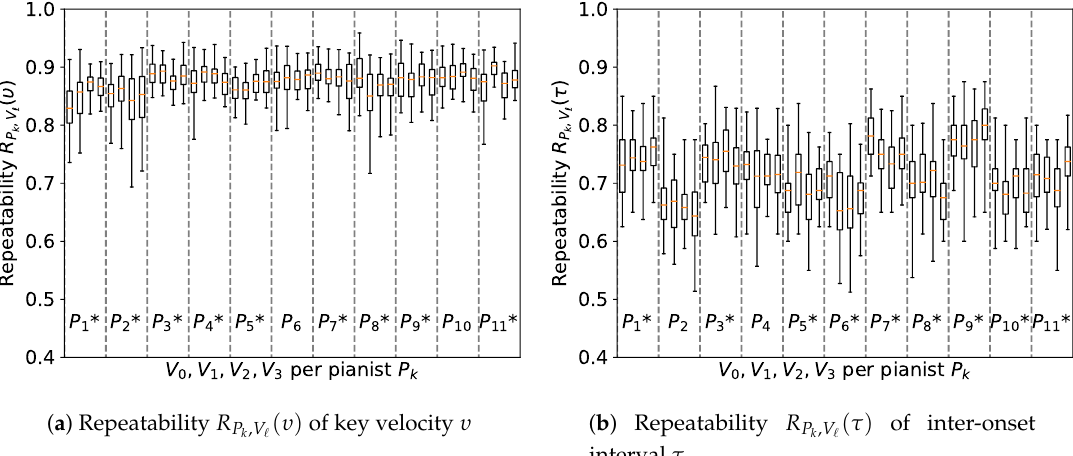
Figure 4. Estimated repeatabilities per participant P k and vibration level V (cid:96) for both performance parameters. No consistent tendency occurred among the pianists, but the vibration levels had a significant influence (marked with *) on repeatability for a majority of the